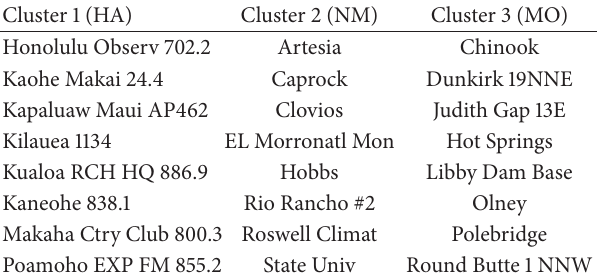
Table 1: The cluster result of 24 stable time series.